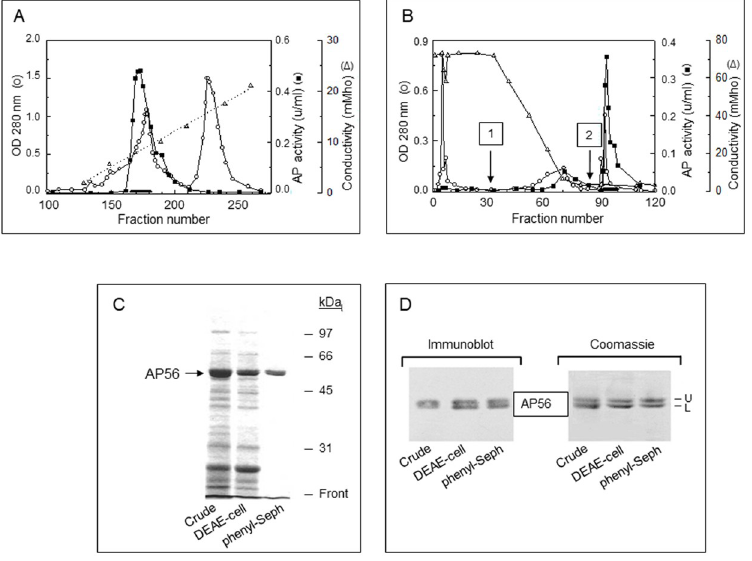
Fig 5. Purification of PaAP from the culture filtrate of strain FRD1185(pSS380). A, DEAE-cellulose chromatography. Fractions containing aminopeptidase activity (black bar) were pooled and prepared for hydrophobic chromatography as detailed in Methods. B , Hydrophobic chromatography on phenyl-Sepharose. Arrows 1 and 2, gradient elution with 0.5–0 M ammonium sulfate and step elution with 4 M urea, respectively. Aminopeptidase activity was determined after removal of the urea by dialysis. C , Progress of purification by SDS-PAGE (10% polyacrylamide, mini-gel, Coomassie staining). Lanes: Crude , concentrated culture filtrate (7 μ g); DEAE-cell , active fraction after DEAE-cellulose chromatography (7 μ g); phenyl-Seph , active fraction after elution from phenyl- Sepharose (0.2 μ g). D , SDS-PAGE (long 8% polyacrylamide gel) and immunoblotting analyses showing that at all stages of purification, the enzyme fractions contained two closely migrating species of about 56 kDa. Crude, DEAE- cell and phenyl-Seph, the same as in panel C. Immunoblot, ~ 0.2 μ g/lane; Coomassie staining, ~1 μ g/lane.